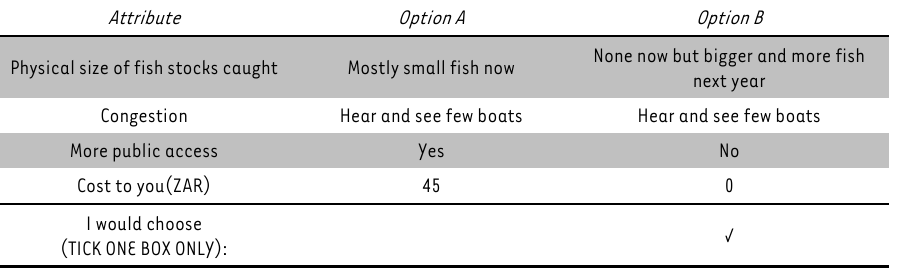
TABLE 3: Sample choice